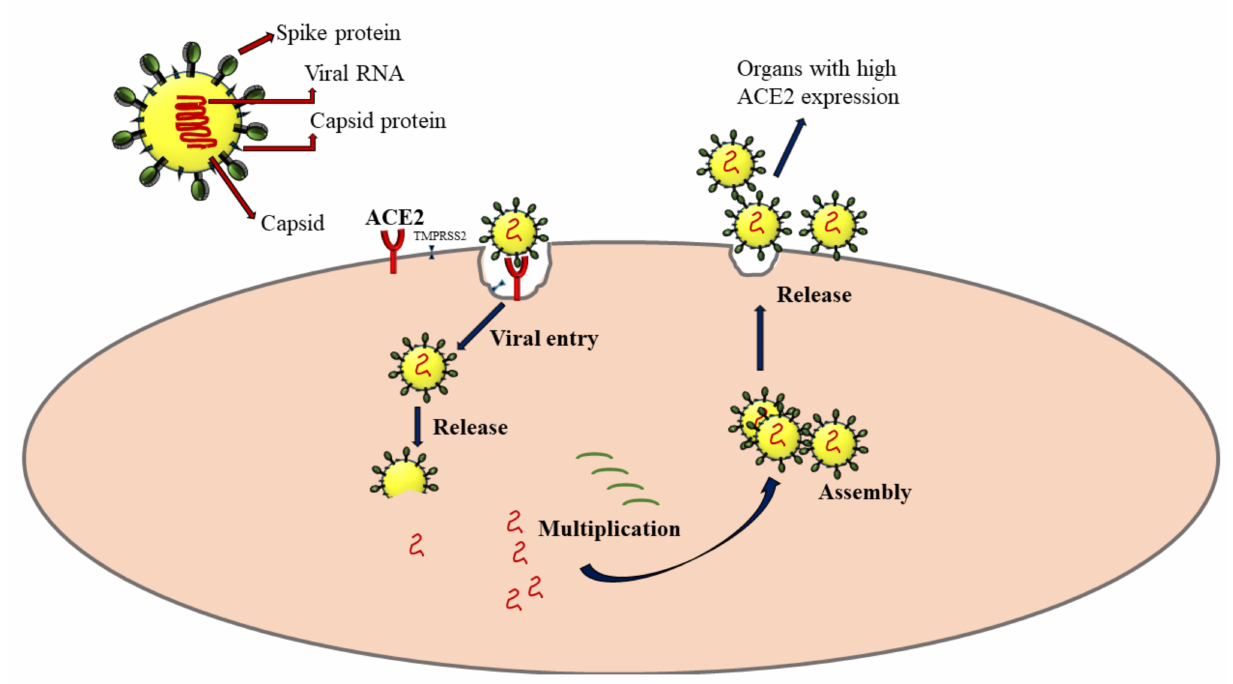
Figure 2. Mechanism of SARS-CoV-2 infection via the interaction with angiotensin-converting enzyme 2 (ACE2) receptors. TMPRSS2: Transmembrane protease, serine 2. The arrows represent the sequence of events following SARS-CoV-2